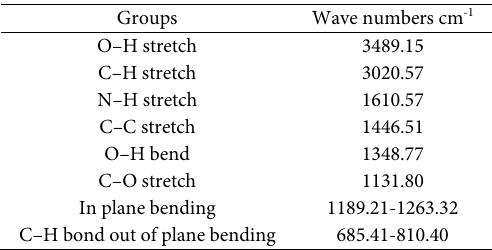
Table 3. FT-IR data of mesalamine-chitosan nanoparticles Groups